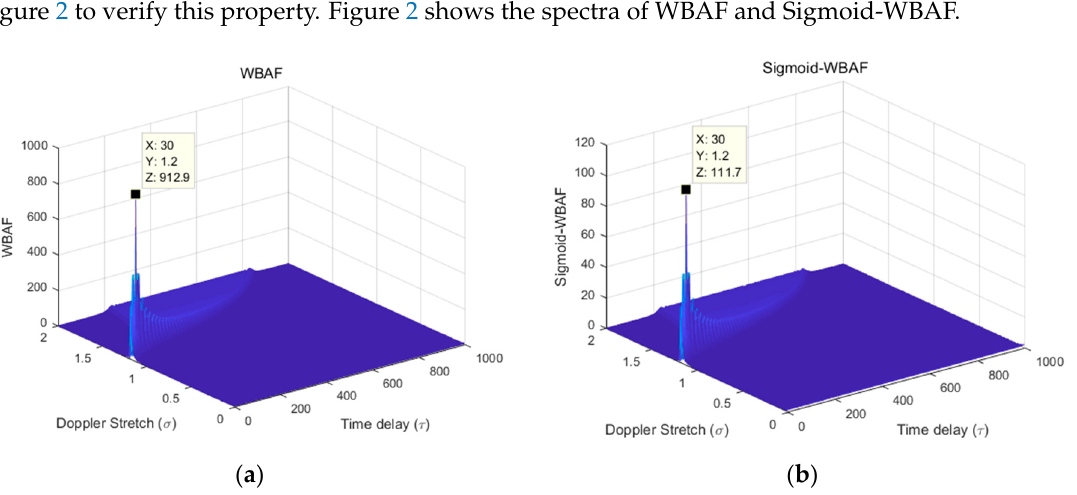
Figure 2. The spectra of ( a ) wideband ambiguity function (WBAF) and ( b ) Sigmoid-WBAF.